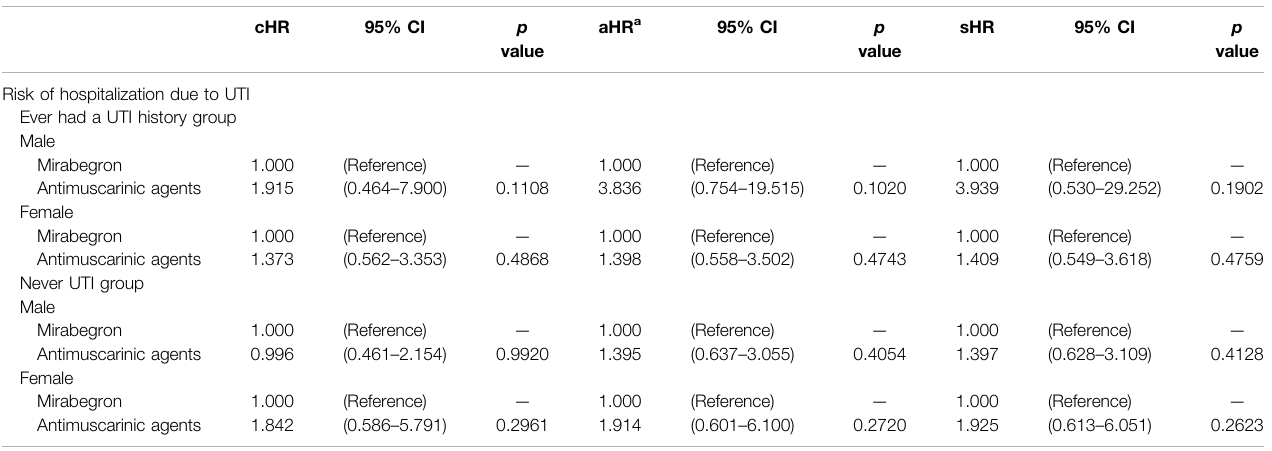
TABLE 6 | Risk of UTI (hospitalization) in sensitivity analysis of drugs with different